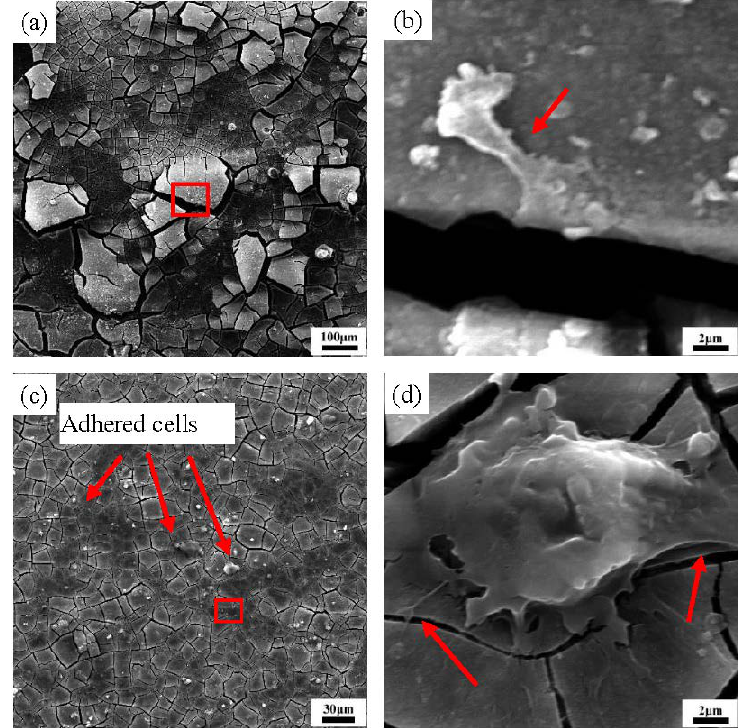
Figure 10. Cells (MC3T3-E1) adhered on the samples: pure Mg ( a ); magnified view ( b ) of red square in ( a ); Mg-1Zn-1.0Sn alloy ( c ); magnified view ( d ) of red square in ( c